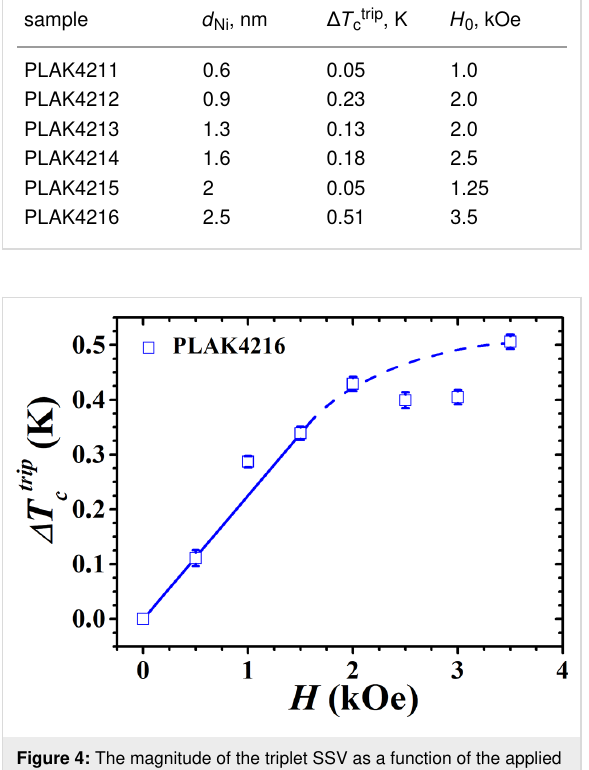
of the experiment in Figure 3 is based on a generalization of [12] along the lines of [27,28]. It allows to consider layered structures with different material parameters of all the